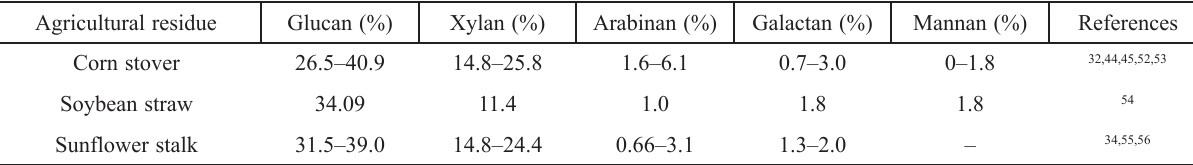
Table 4 – Polysaccharides composition in corn, soybean and sunflower harvest residues Agricultural